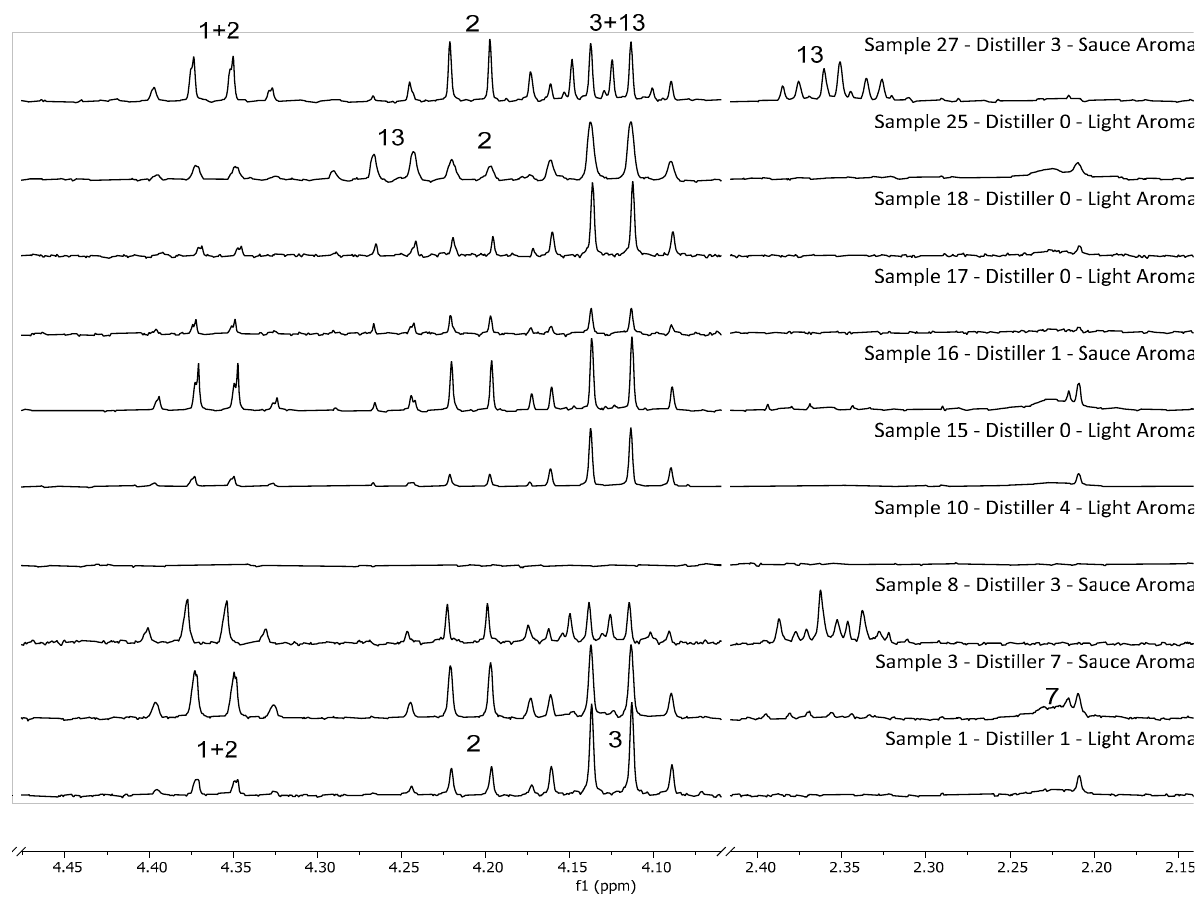
Figure 6. 1 H NMR—ethyl ester region—stacked plot comparisons of 10 of 30 baijiu samples analyzed in this study. Sample 10 stands out as a potential counterfeit sample, as it only shows the presence of ethanol. No congeners are observed, as in the other samples. The numbered assignments are as follows: 1. lactic acid, 2. ethyl lactate, 3. ethyl acetate, 7. acetaldehyde, 13. higher esters CH 2 adjacent to carboxyl—butyric, caproic.